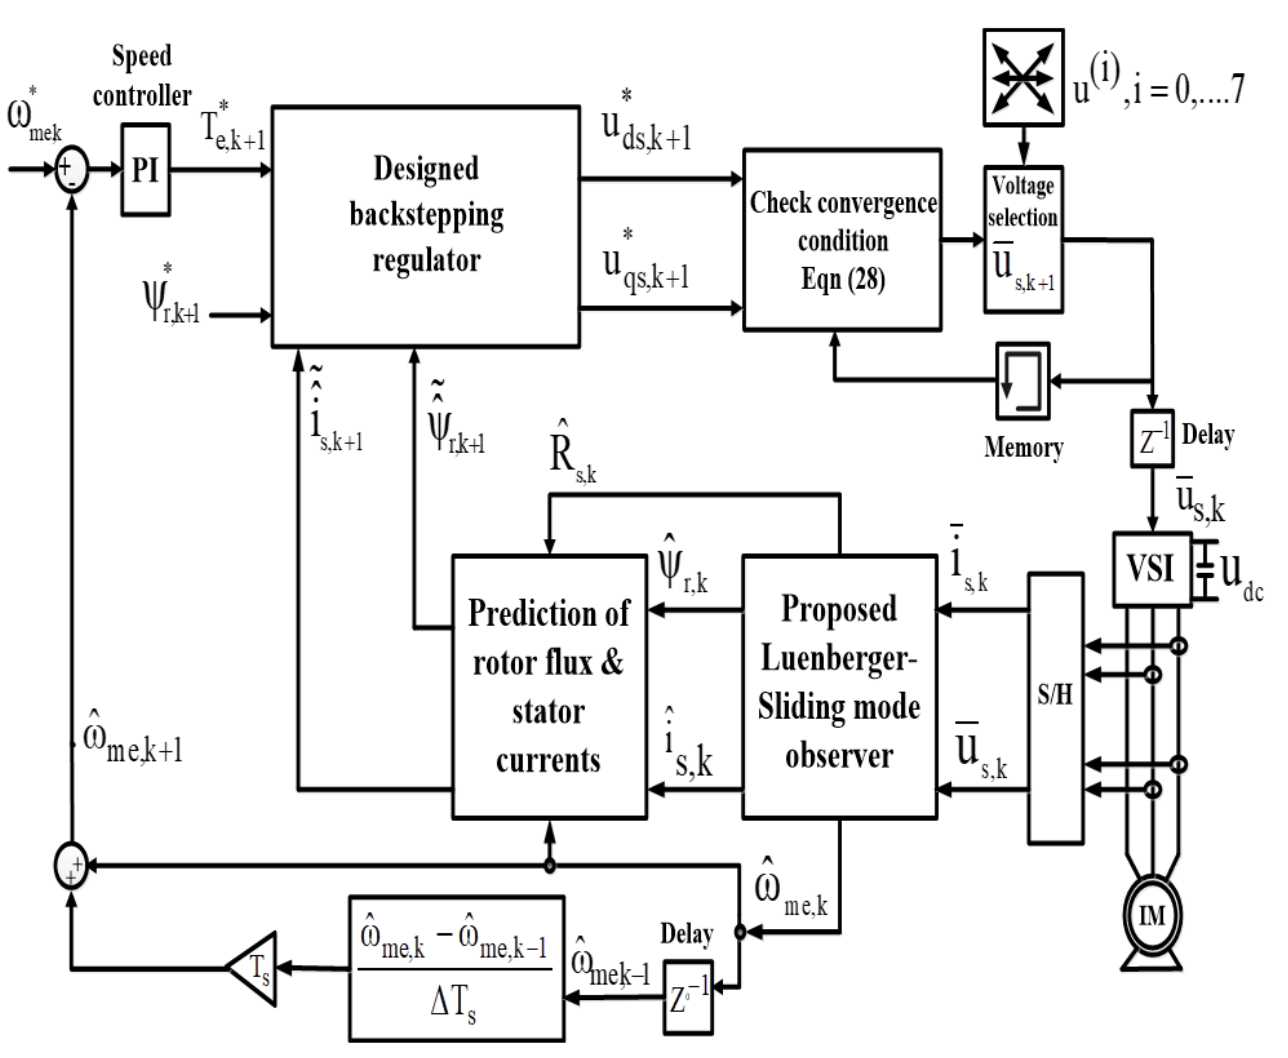
Figure 7. Overall control scheme for IM drive.